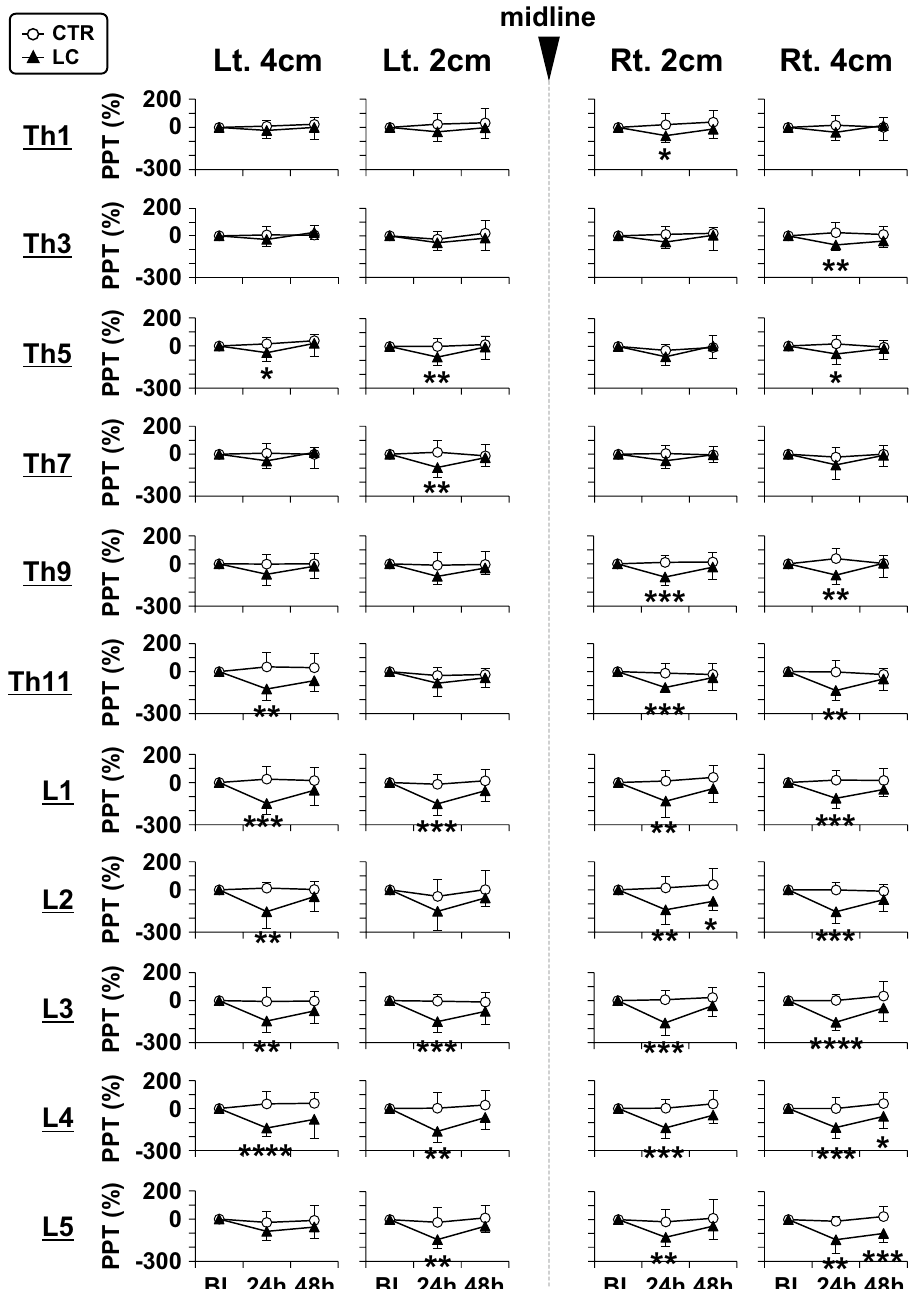
Figure 6. Normalized changes in pressure pain thresholds (PPTs) after lengthening contractions (LCs). PPTs were normalised in the CTR (n = 12) and LC (n = 12) groups. The mean PPTs in each group before LC were set to 0%. * p < 0.05, ** p < 0.01, *** p < 0.001, and **** p < 0.0001, CTR vs. LC at each time point of measurement, two- way repeated measures ANOVA followed by Sidak’s multiple comparison